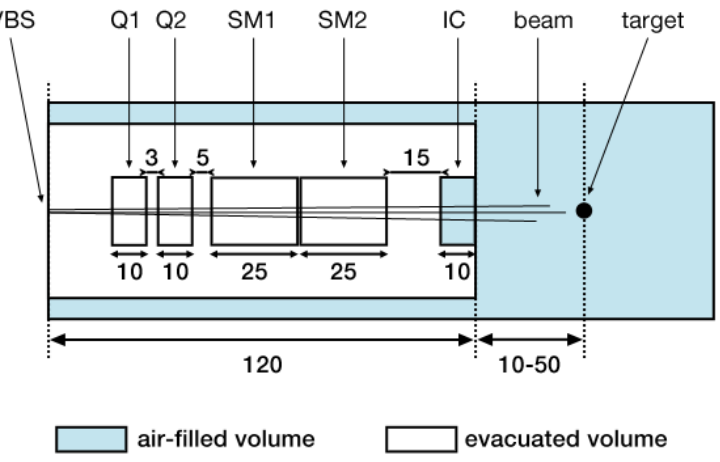
Figure 1. Schematic of the new nozzle design with dimensions in cm. Abbreviations: VBS - virtual beam source, Q—quadrupole, SM—scanning (dipole) magnet, IC—ionisation